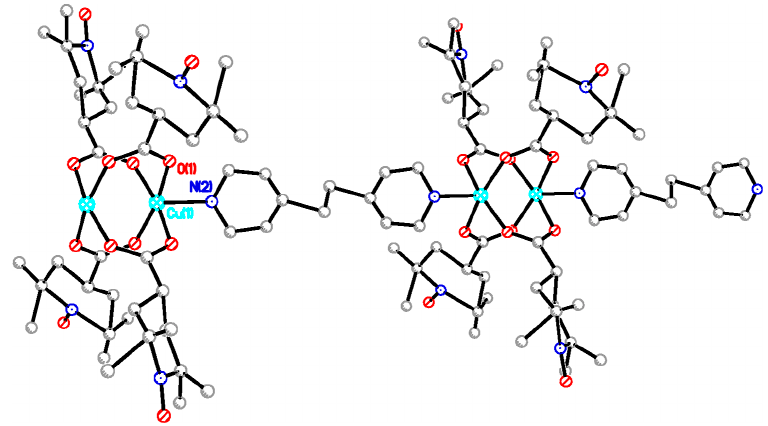
Figure 10. Perspective view of chain molecule for [Cu 2 (catempo) 4 (bpe)] n ( 10 ). Hydrogen atoms are omitted for clarity.